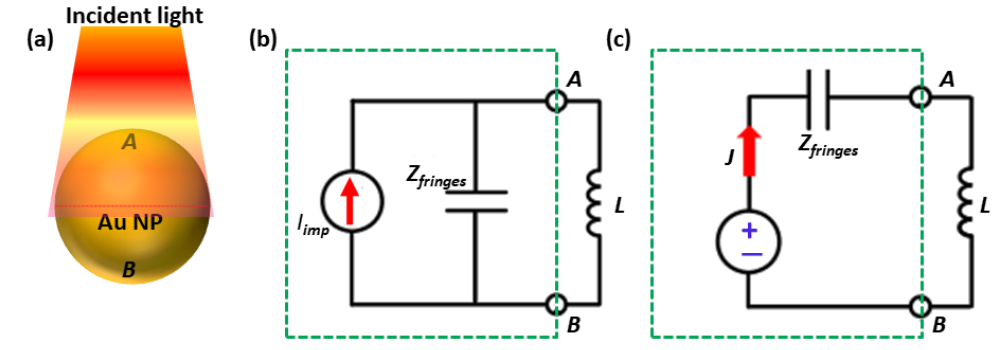
Figure 2. Plasmonic NP-based nanocircuit models. ( a ) Au NP with two terminals A and B as defined on the upper and lower hemispherical surfaces of the NP, ( b ) Norton and ( c ) Thevenin equivalent nanocircuits excited under the illumination of uniform